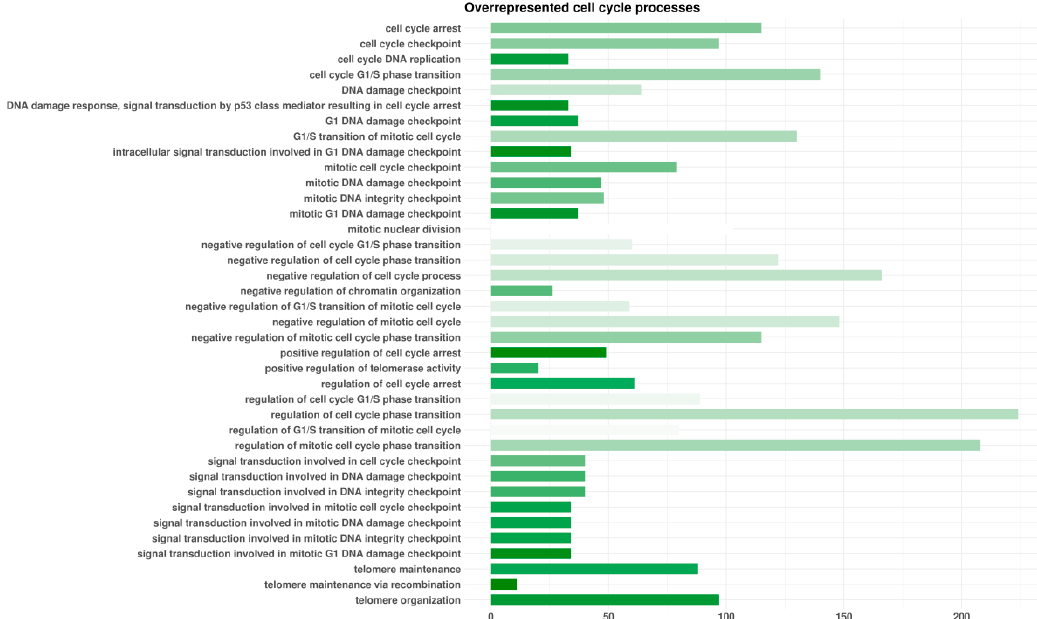
Figure 2. Enriched biological processes terms involved in cell cycle by differentially expressed genes (DEGs) found in HCN-2 cells after exposure to SARS-CoV-2. For each Gene Ontology term represented, the length of the bar shows the number of DEGs observed in that specific category. The color of the bar points to the ratio between the number of DEGs found in our analysis and the number of genes included in the term from white (no DEGs of the term) to green (all DEGs of the term). The terms are alphabetically